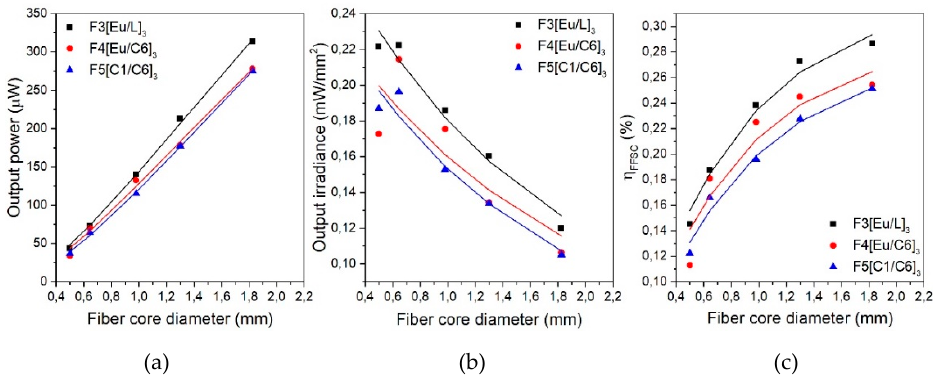
Figure 5. A representative model of the transversal excitation conditions and of the distance covered by rays reflecting at the cladding-air interface in fibers with the same cladding and different core radius (r < r ′ ). P and P ′ represent the power of the transversal excitation light ( P lamp ) that is not absorbed by the doped core and goes through the fiber. Fibers with greater core radius absorb more light transversally than fibers with smaller core radius ( P > P ′ ). Table 2. Output power in ( μ W), output irradiance in (mW/mm 2 ) and η FFSC in (%) for the three samples and different fiber diameters without and with a reflective layer at 4.5 cm from the fiber.